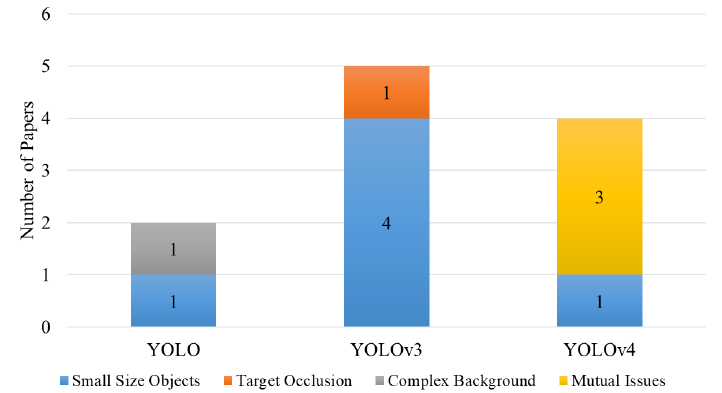
Figure 16. Classification of One-Stage Detectors in DL.